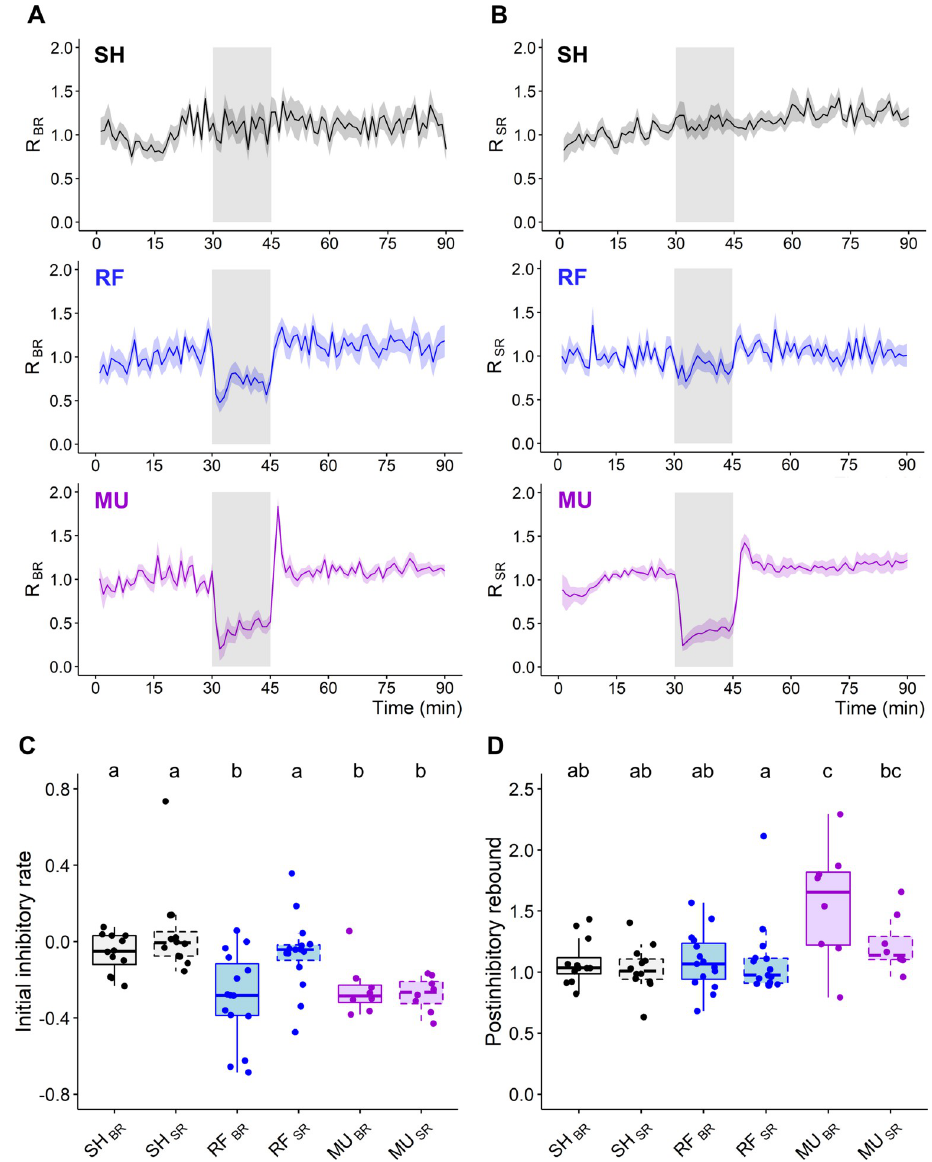
Fig 3. Temporal dynamic of RF and MU-induced inhibition on bursting and spiking rates. (A-B) Normalized temporal time course of bursting rate (BR, left) and spiking rate (SR, right) over 90 min for SH (top), RF (middle) and MU (bottom) groups (1 min bin-size, data show as Mean ± SEM). The exposure phase is symbolized by a gray shadowed area. (C) Initial inhibitory rate in response to RF and MU exposure. (D) Quantification of the postinhibitory rebound in response to treatment cessation. Boxplots with dashed box denote SR data. SH, n = 12; RF, n = 15; MU, n = 8. (C-D). Lower case letters indicate significant differences between